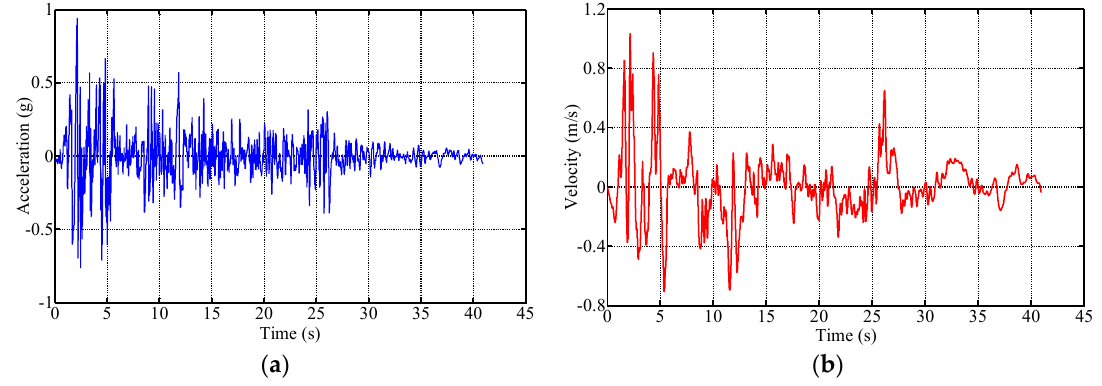
Figure 7. The El ‐ Centro waveform curves. ( a ) The acceleration curve; ( b ) The velocity curve. Figure 7. The El-Centro waveform curves. ( a ) The acceleration curve; ( b ) The velocity